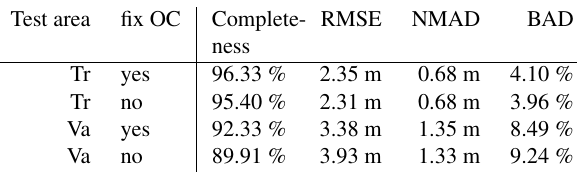
Table 3: Over-counting evaluation on Pleiades Triplet. The La Mola region was not included, as the very dark shadows without image details in the mountainous regions lead to large no-data regions. The BAD column gives the percentage of pixels with errors > 5 m.